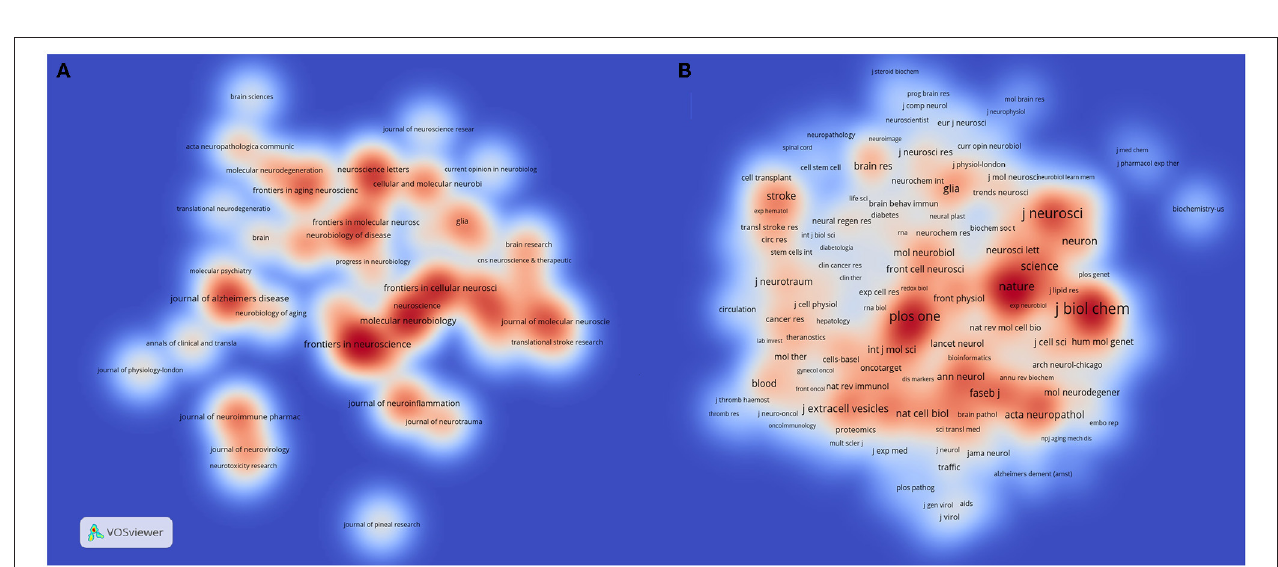
FIGURE 11 | (A) Journal density map based on publication number of researches on exosomes in the field of neuroscience. (B) Journal density map based on co-citation analysis results on exosomes in the field of neuroscience.